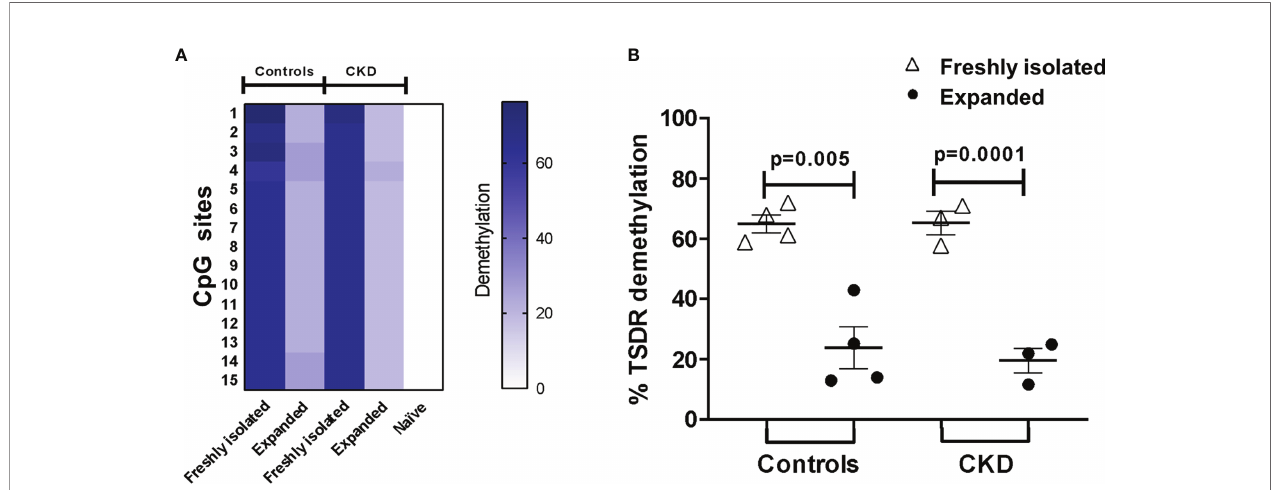
FIGURE 5 | Long-term expansion reduced the demethylation of TSDR- Foxp3 in puri fi ed allospeci fi c regulatory T cells (Tregs). CpG methylation analysis of the Treg- speci fi c demethylated region (TSDR) in the Foxp3 gene was evaluated in puri fi ed CD4 + CD25 hi CD127 − Tregs (freshly isolated) and in expanded alloantigen-speci fi c Tregs ( allo Tregs). (A) Each square represents one CpG site analyzed (of a total of 15 CpGs). Six to seven clones per DNA sample were sequenced. The demethylation color code ranges from white (0% demethylation) to navy blue (80% demethylation), according to the color scale. Puri fi ed CD4 + CD25 − CD45RA + T cells (naive) displayed a completely methylated TSDR and were used as the negative control. (B) Freshly isolated Tregs from both groups displayed high demethylation of TSDR- Foxp3 , while expanded allo Tregs showed a signi fi cant increase in the methylation of the TSDR. DNA samples from three male chronic kidney disease (CKD) patients and four male healthy controls were analyzed. The results are expressed as the mean ± SEM. Statistical analysis was performed using paired t